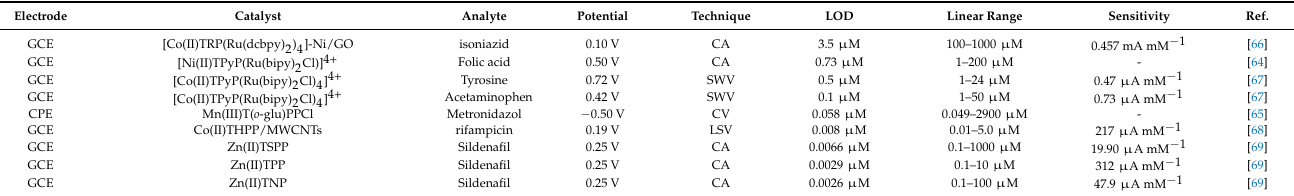
Table 7. Electrochemical based on MP for sensing